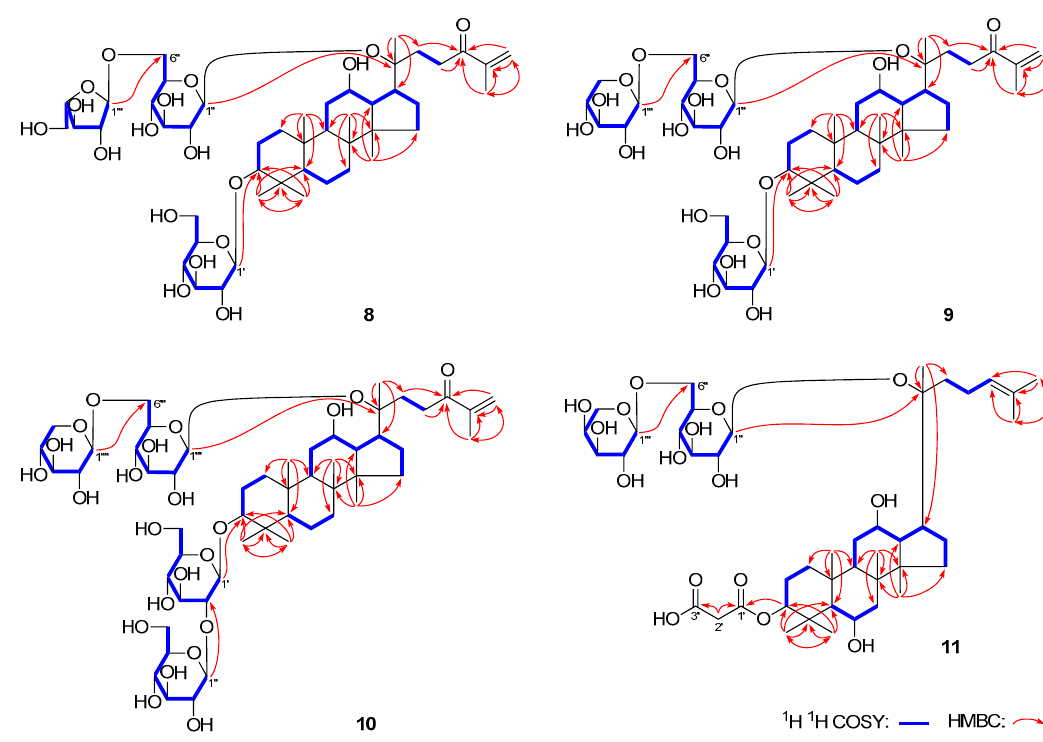
Figure 2. Key 1 H– 1 H COSY and HMBC correlations of 1 − 11 .